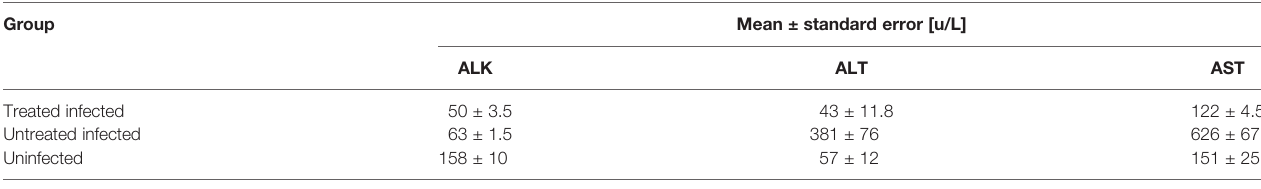
TABLE 3 | The effect of treatment on liver functions of treated, and untreated infected mice. Group